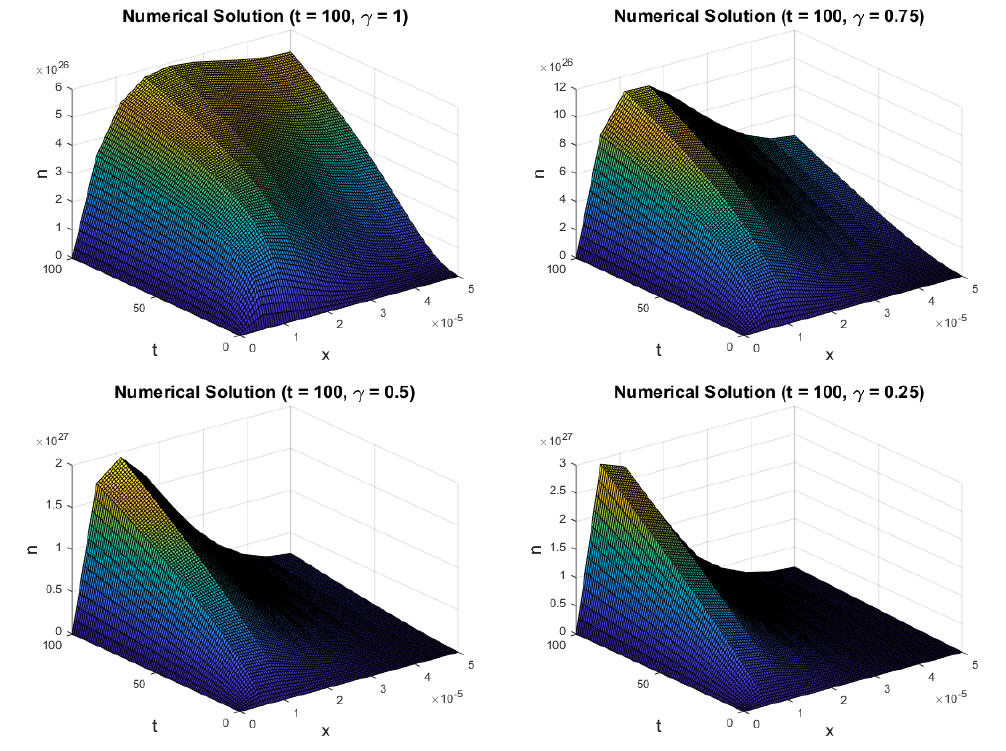
Figure 1. Plots of the numerical solution to Equation (3) against x and t for γ = 1 (top-left), γ = 0.75 (top-right), γ = 0.5 (bottom-left), γ = 0.25 (bottom-right).